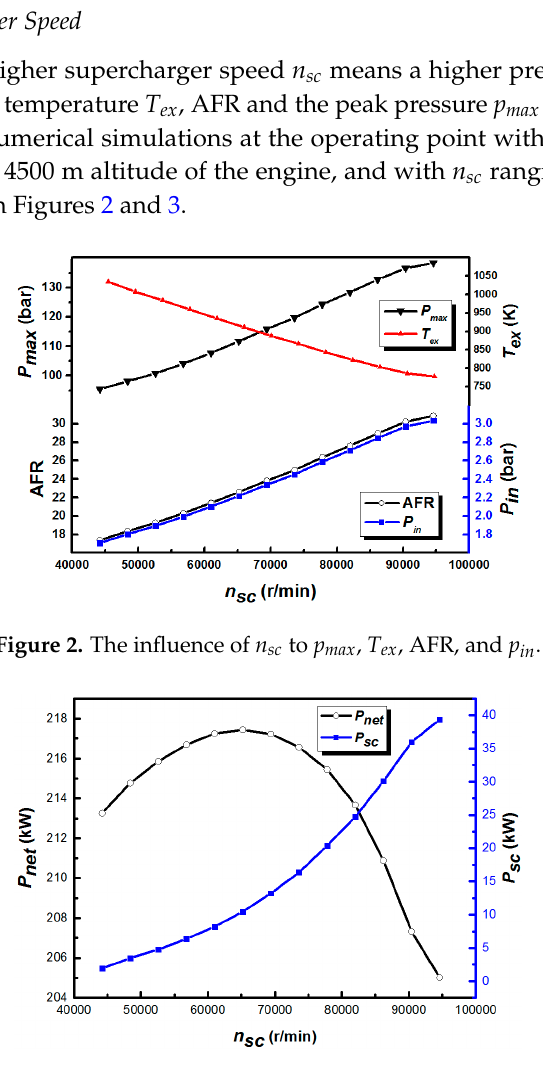
Figure 3. The influence of n sc to P net and P sc .